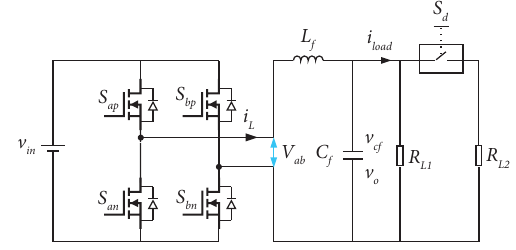
Figure 1: Te single-phase full-bridge